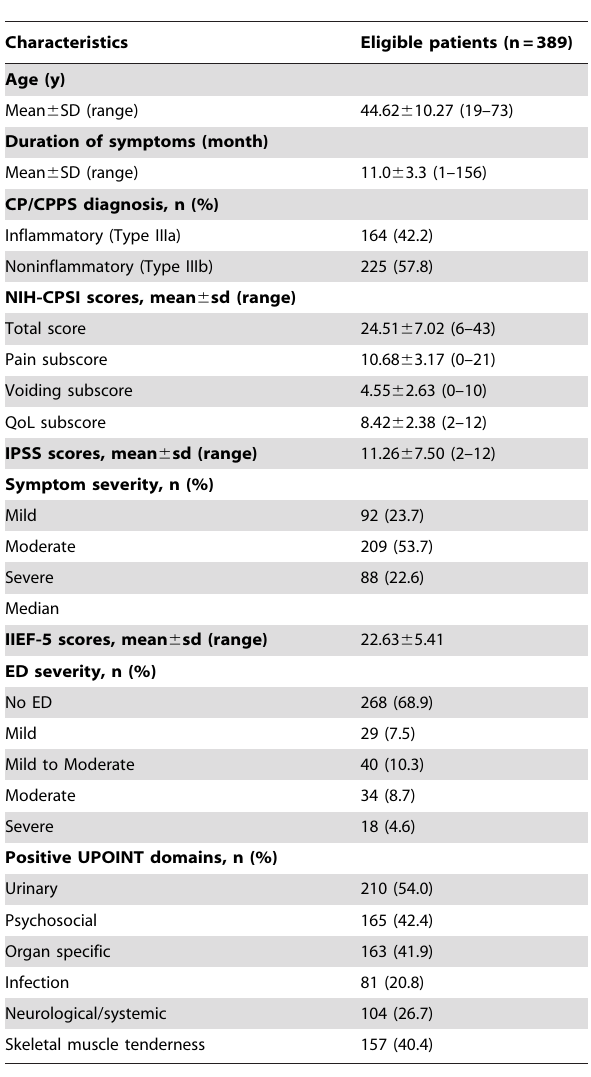
Table 1. Demographic and clinical characteristics of the patient cohort.